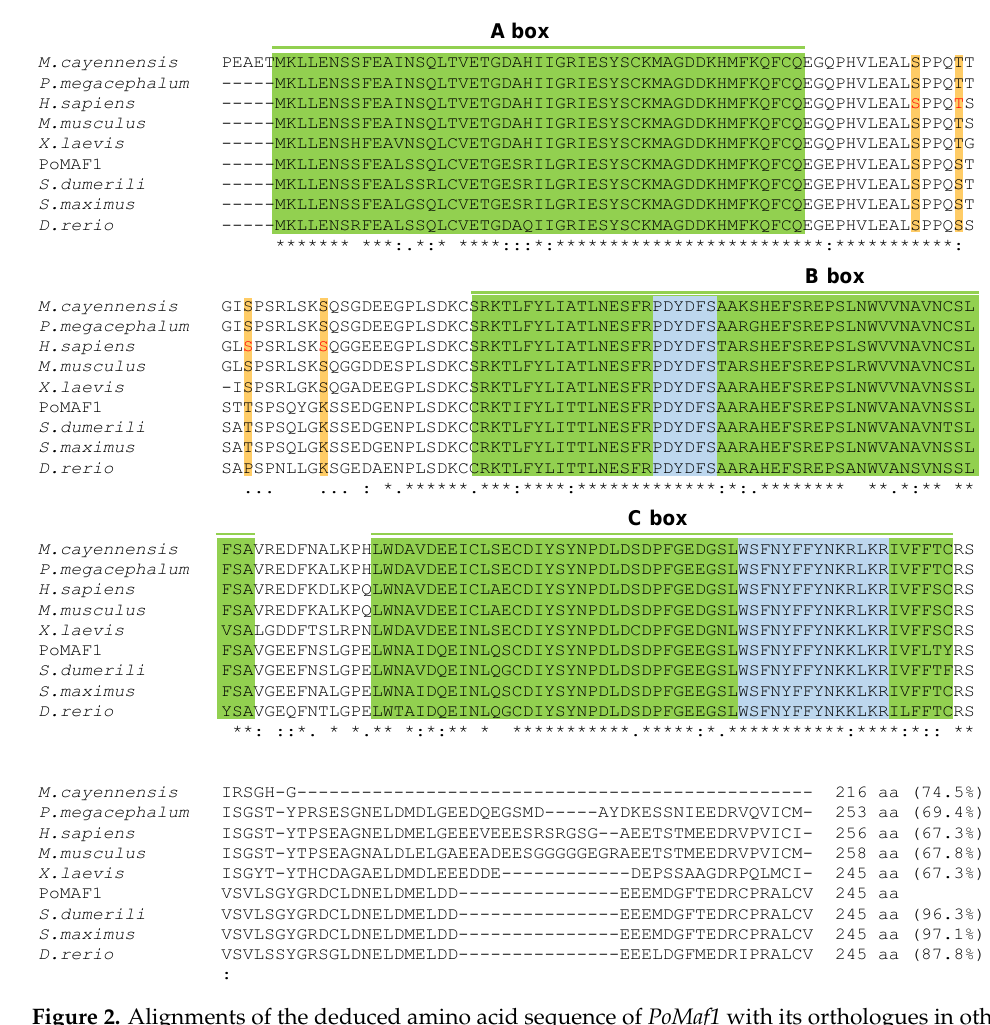
Figure 2. Alignments of the deduced amino acid sequence of PoMaf1 with its orthologues in other vertebrates: Mesembrinibis cayennensis (NXL10327.1), Platysternon megacephalum (TFJ99060.1), Homo sapiens (AAH14082.1), Mus musculus (AAH16260.1), Xenopus laevis (NP_001080708.1), Seriola dumerili (XP_022622762.1), Scophthalmus maximus (XP_035474856.1), and Danio rerio (NP_001025410.1). Identical and similar residues are marked by asterisks (*) and colons (:), respectively. Residues that are somewhat similar are denoted by dots (.). A, B, and C boxes with high similarities in the MAF1 orthologues are boxed in green. The two MAF1 signature sequences, which are conserved in PoMAF1, are shown in blue. Thr and Ser residues that are phosphorylated in human MAF1 are indicated in red, and putative phosphorylated sites are boxed in orange. Similarity scores compared to PoMAF1 are shown at the end of the deduced amino acid sequences.